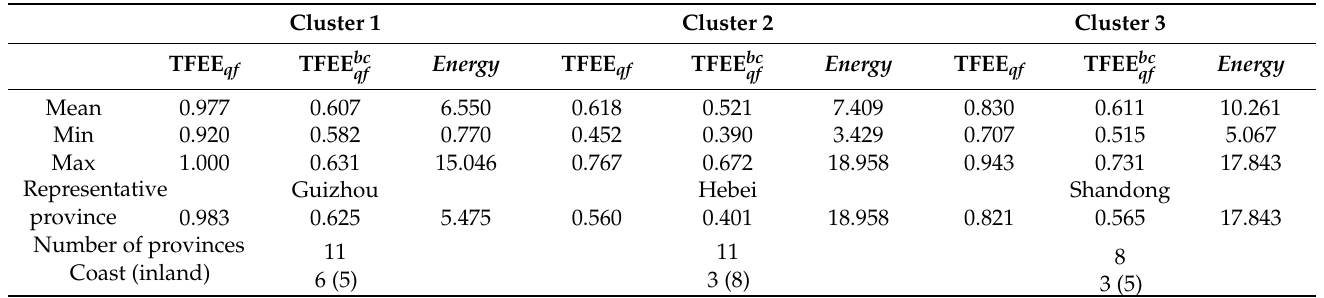
Table 6. Results of partitioning around medoids (PAM) for k =